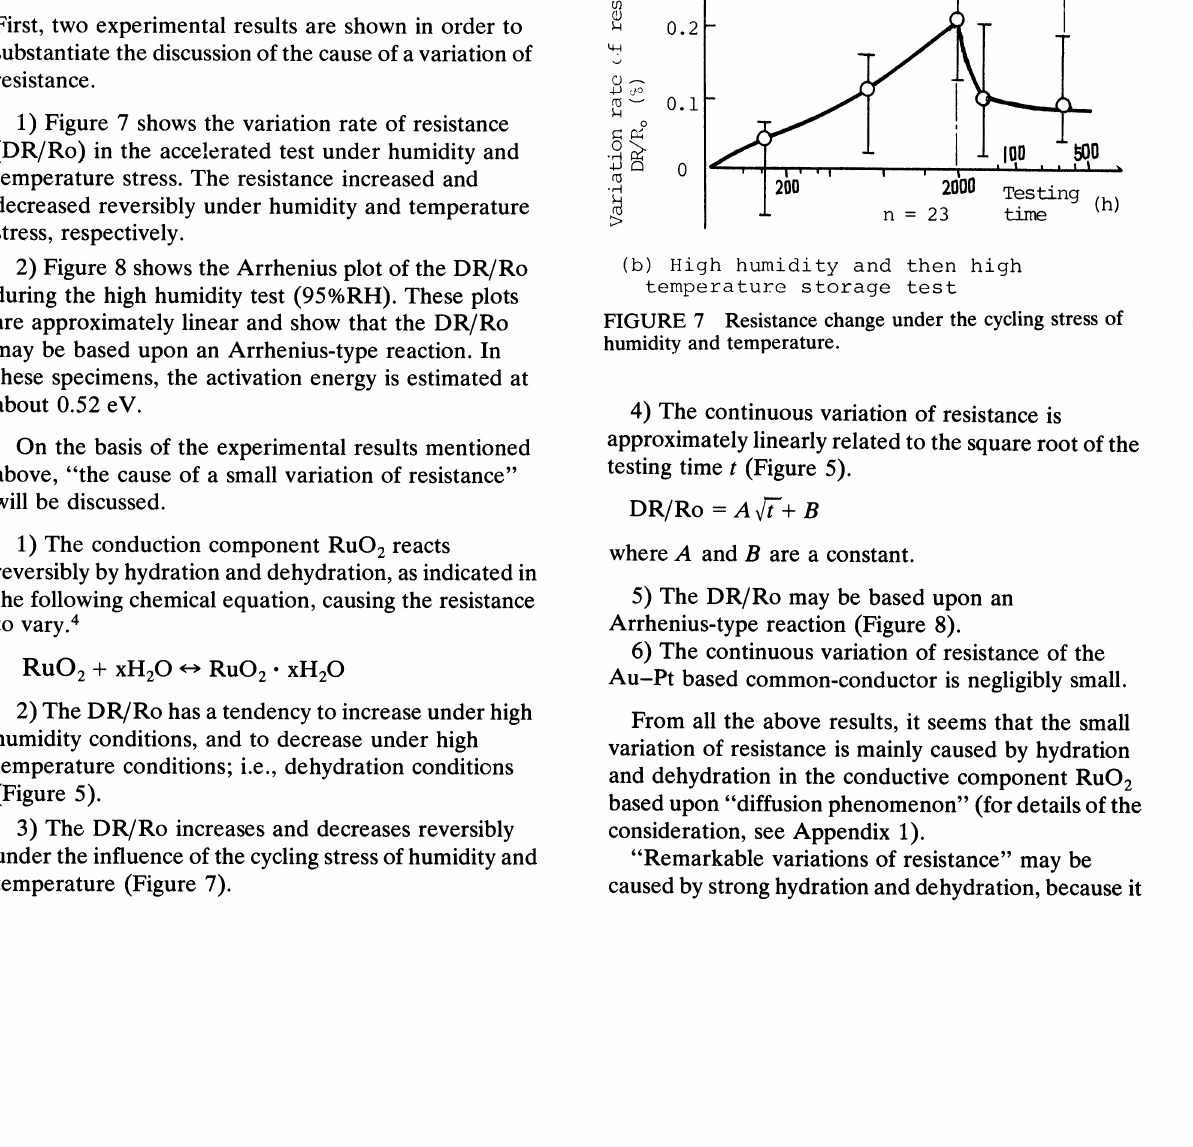
FIGURE 6 Continuous variation of resistance under various electrical tests (THI < -122 dB).